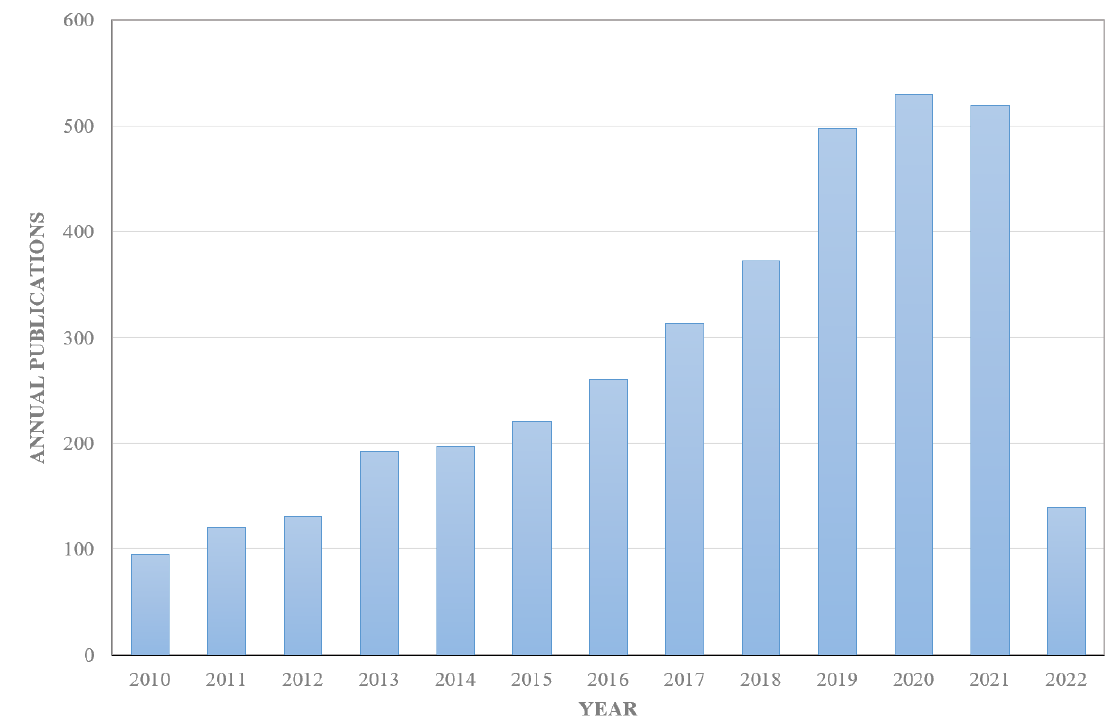
Figure 1. Annual publications from 2010 to 2022. Search Web of Science for the terms: “cellulose” and “tissue engineering”.